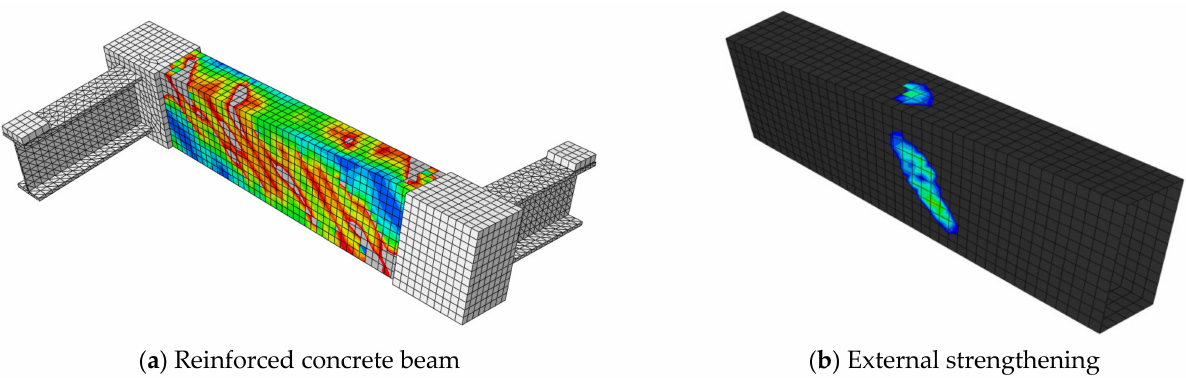
Figure 32. FE final cracks of beam B3-GFRP at the ultimate torque.